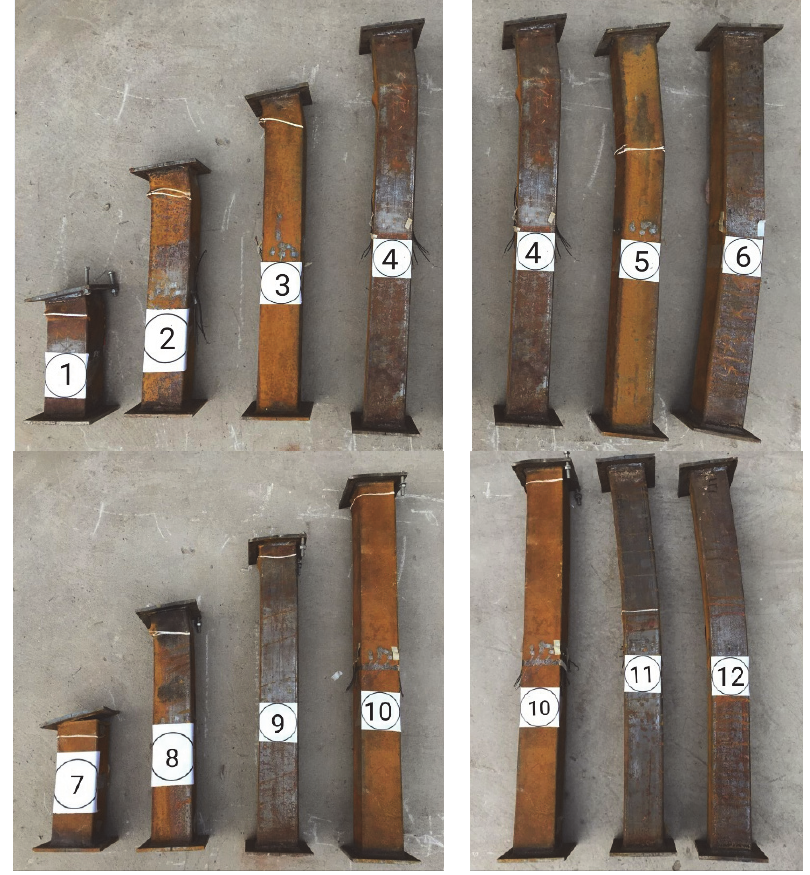
Figure 3: Failure forms of